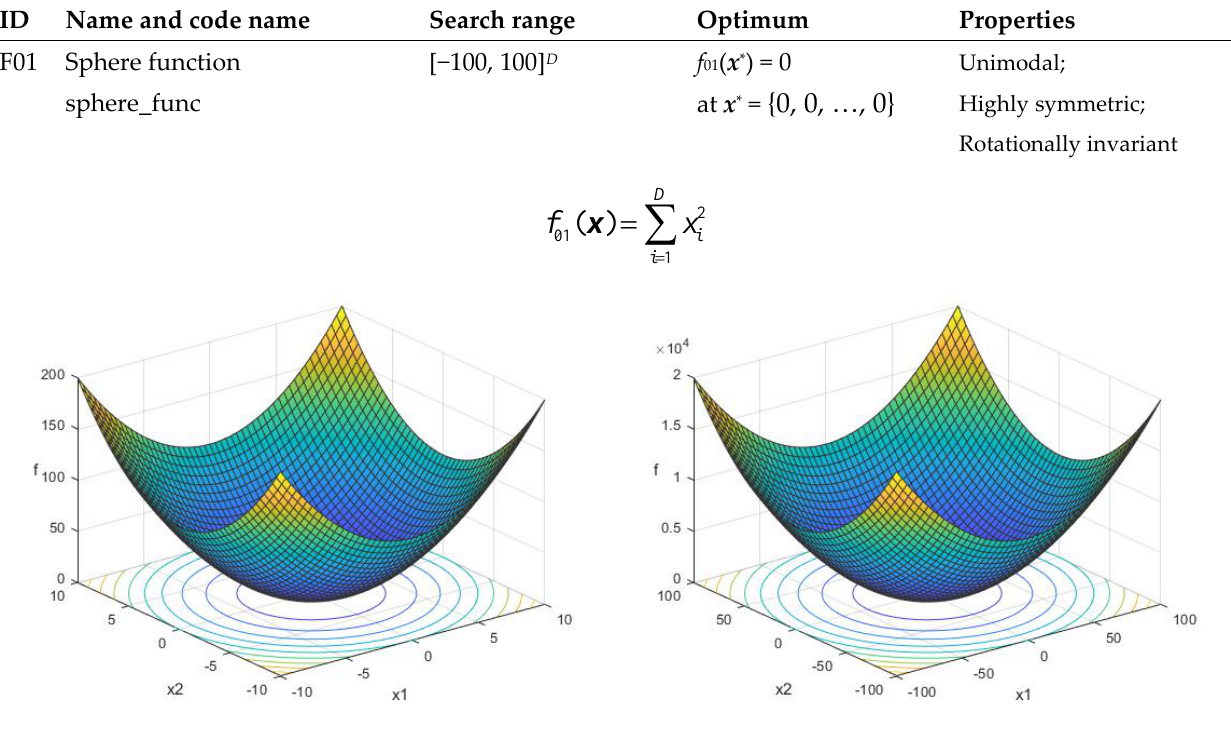
Figure A1. Sphere function in two dimensions.